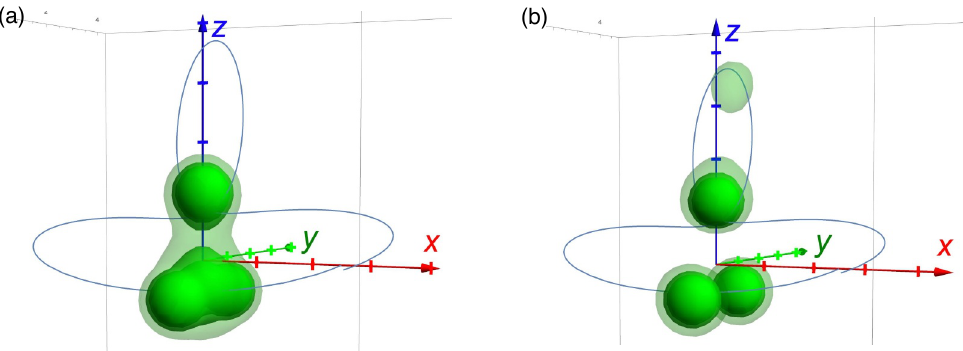
Figure 3 . Two frames from a simulation with q = 0 and C = 3 . The initial position of the smooth monopole is taken as ~ R = (2 . 5 , 0 , 0) , and the initial momentum is ~ p = ( − 1 . 1 , 0 ., − 0 . 5) . The 0 0 trajectory is shown in blue from τ = 0 to τ = 17 . 5 , and the frames correspond to τ = 1 . 5 and max τ = 10 for (a) and (b)